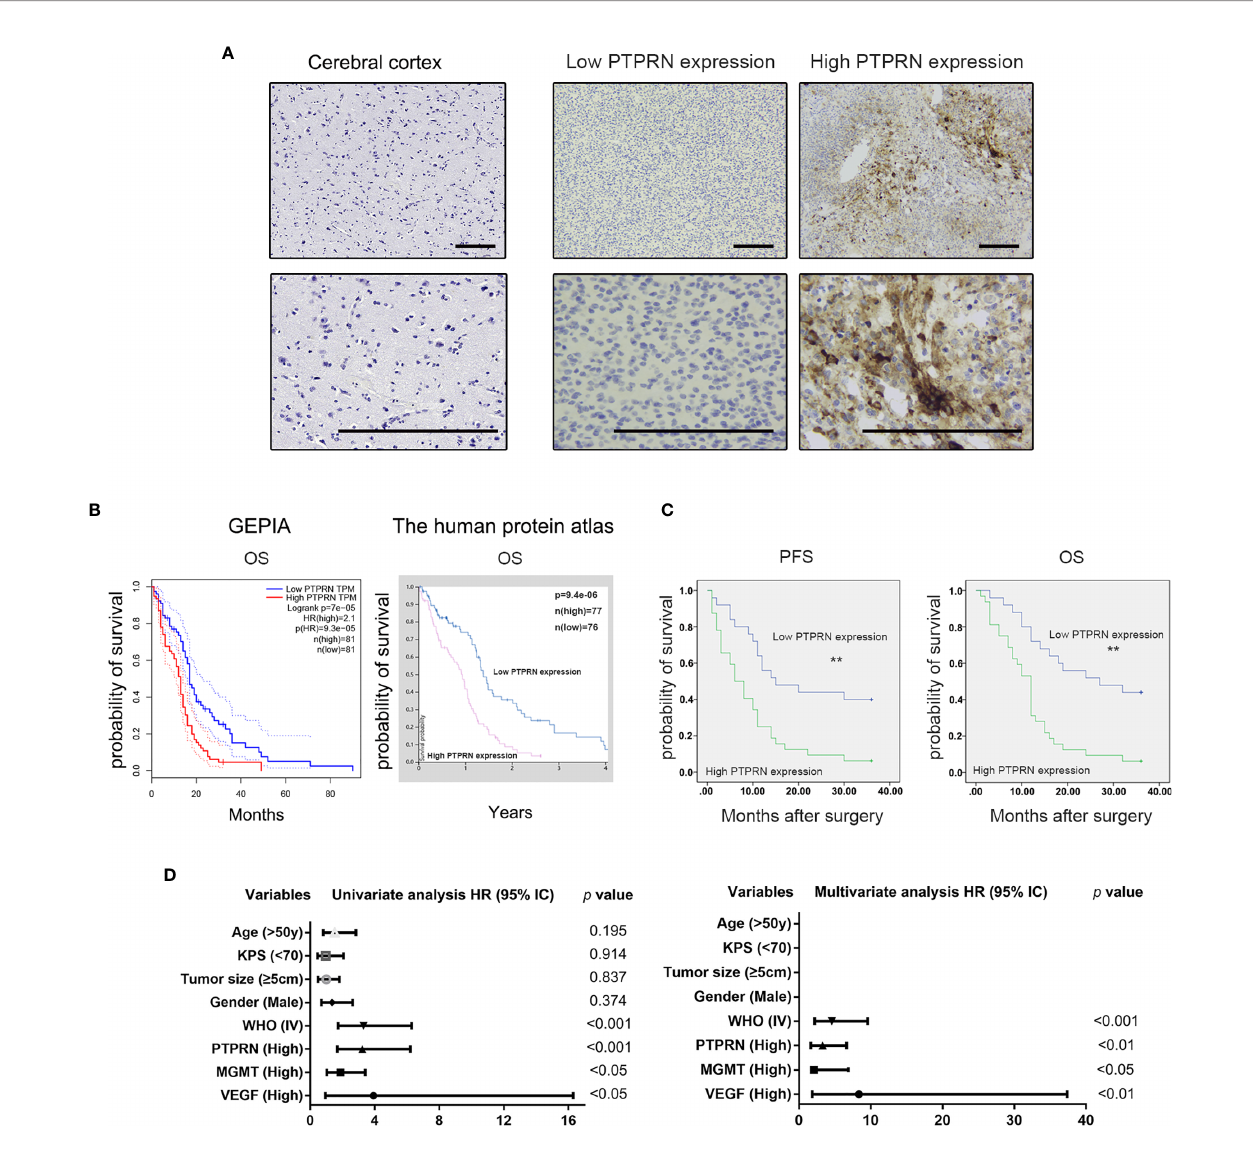
FIGURE 1 | High expression of PTPRN indicated a poor prognosis of high-grade glioma. (A) PTPRN expression detected by immunohistochemistry staining in cerebral cortex tissue (negative) and glioblastoma (low and high PTPRN expression); (B) Survival analysis of PTPRN expression based on the GEPIA and Human Protein Atlas database (log-rank test); (C) Survival analysis of PTPRN expression in fi fty-seven high-grade glioma patients (log-rank test); (D) Univariate and multivariate survival analysis between PTPRN expression and clinicopathological parameters; scale bars, 100 m m; **p <